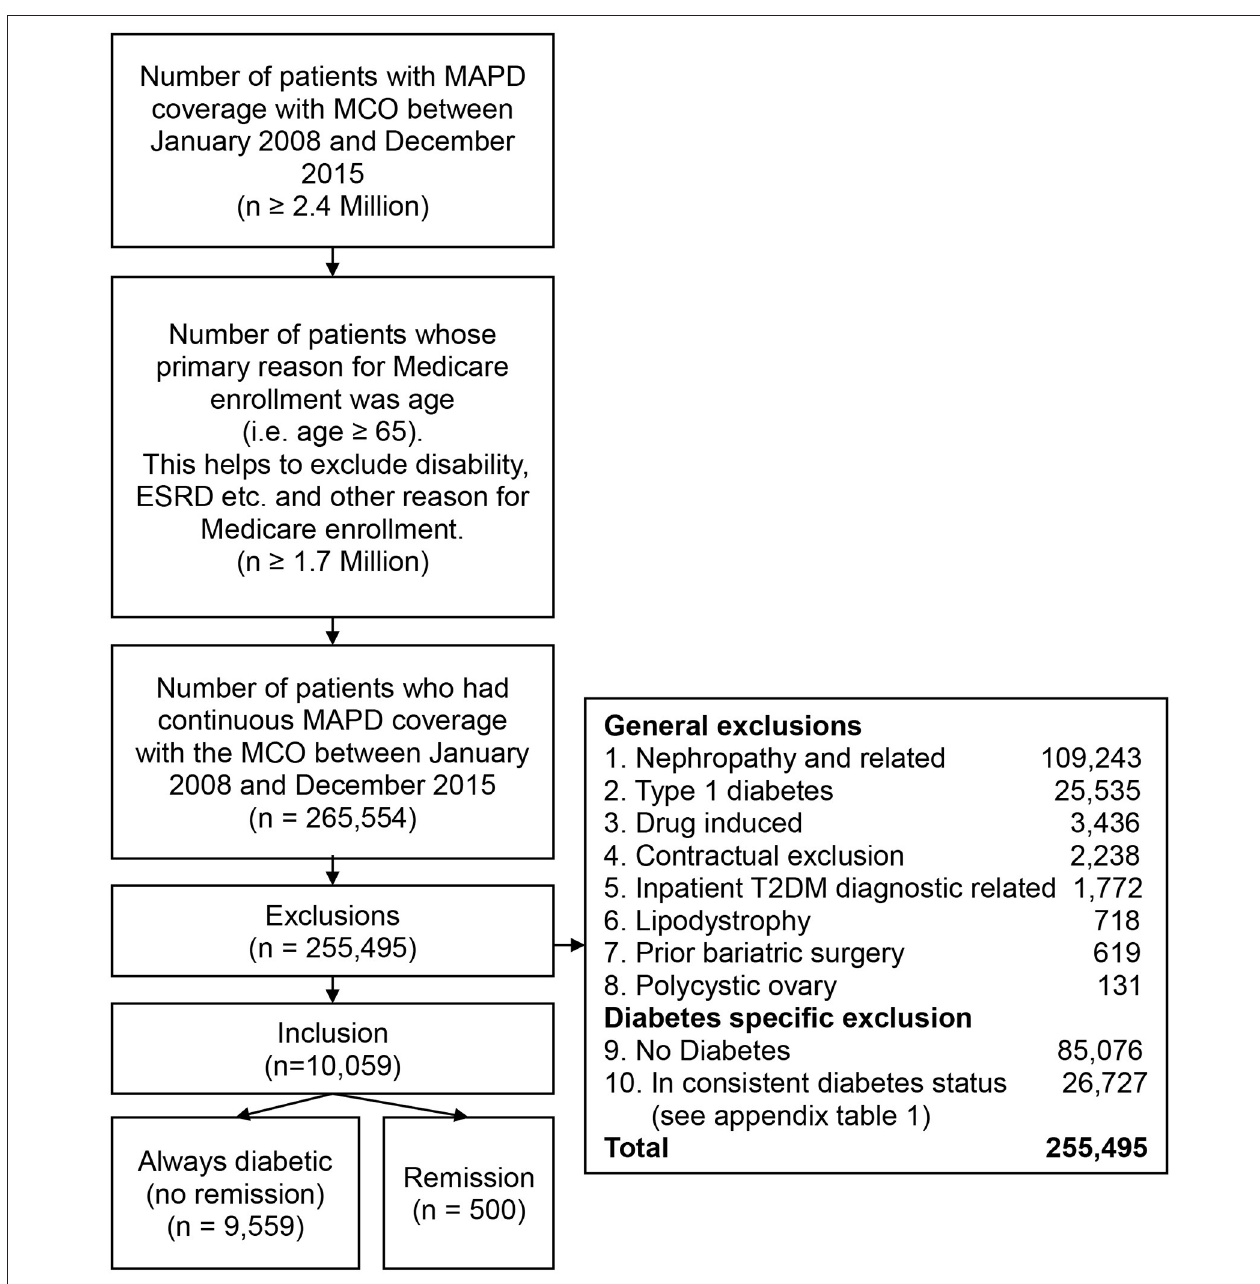
FIGURE 1 | Inclusion and exclusion